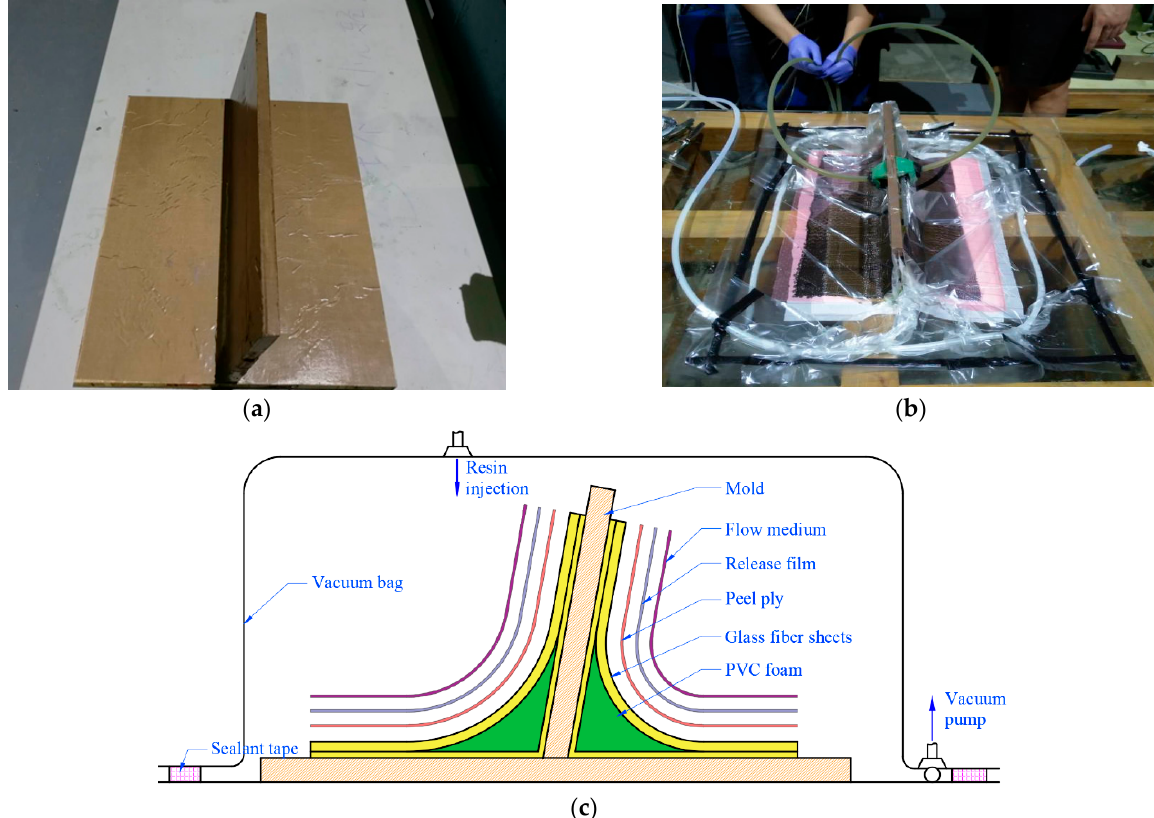
Figure 3. Preparation of T-joint: ( a ) mold of T-joint; ( b ) resin injection; ( c ) stacking sequence.